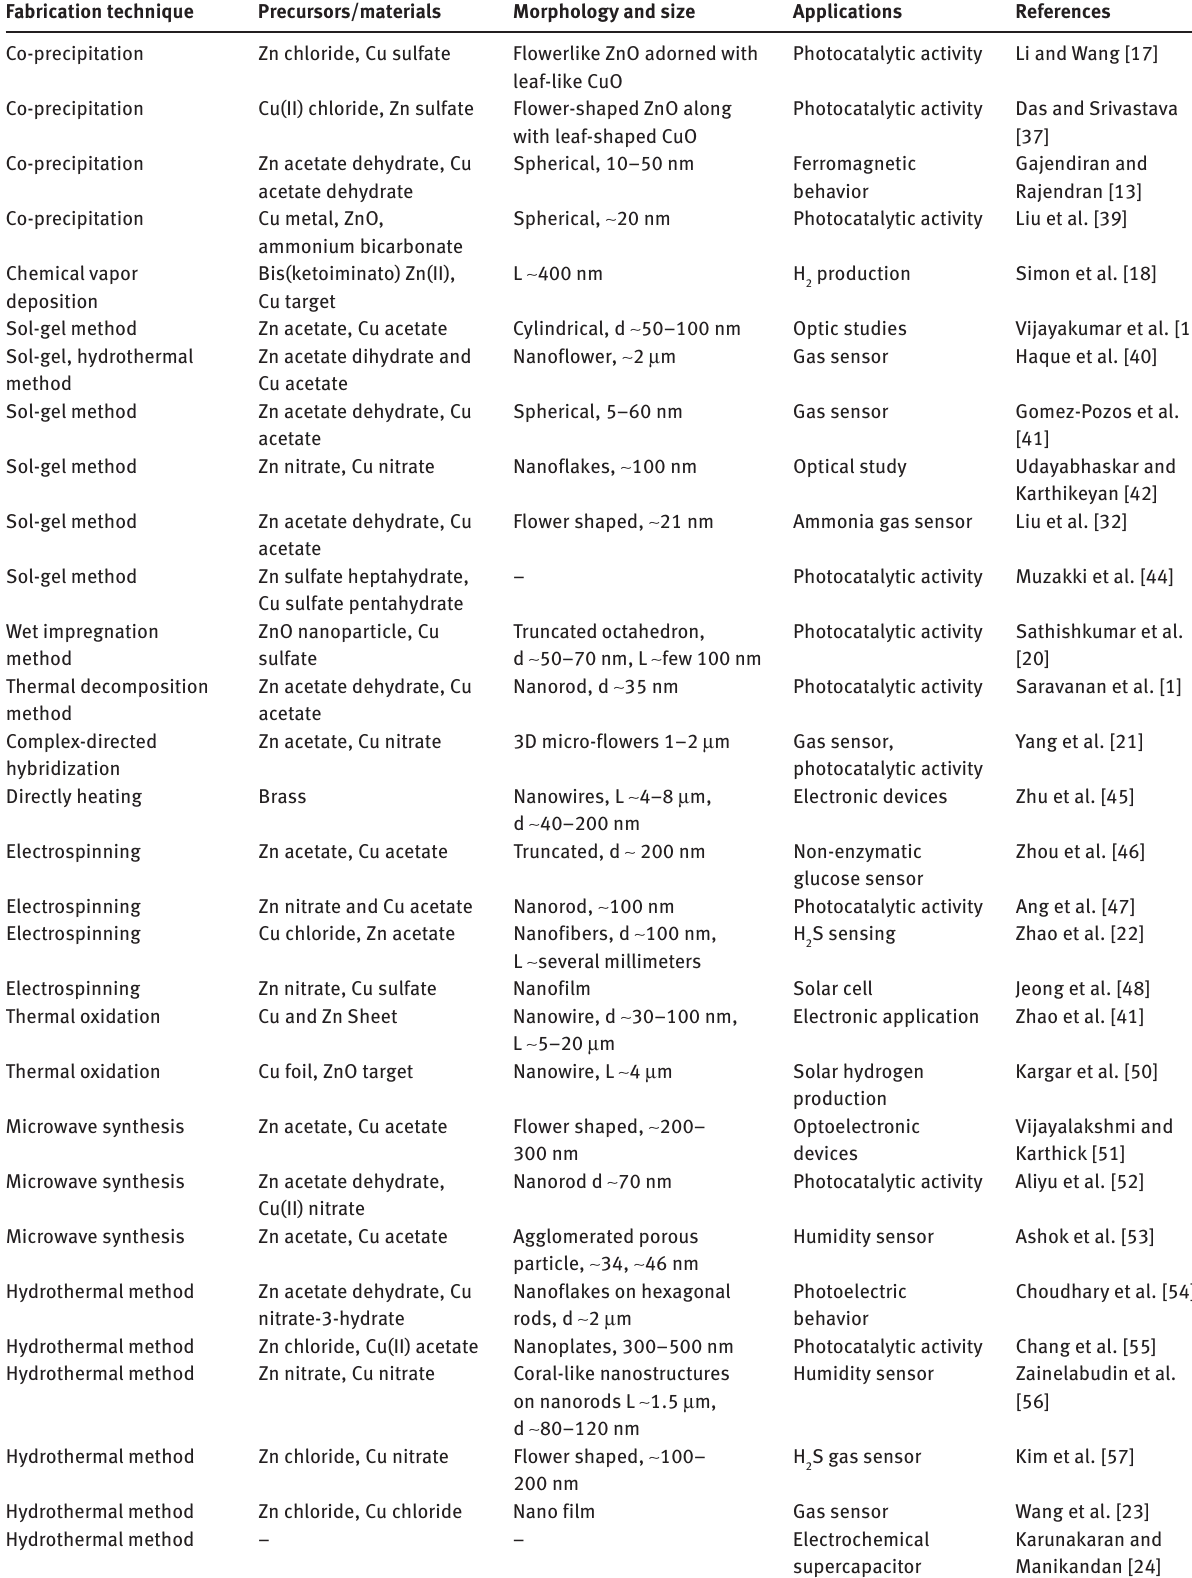
Table 3: Summary of CuO-ZnO nanocomposite synthesis technique, morphology, and its various applications. Fabrication